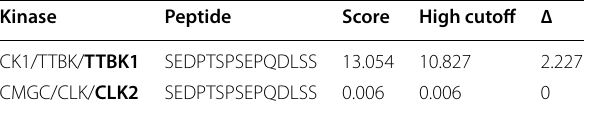
Table 6 Possible kinases for the mutant S403 site Kinase